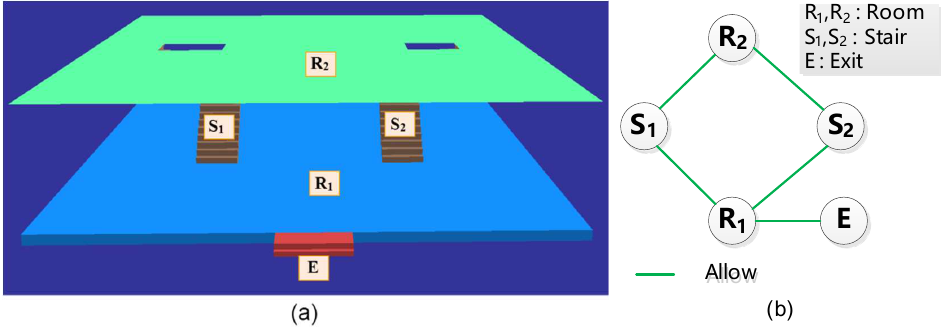
Figure 6. The spatial environment for Case 1: ( a ) the 3D spatial model; ( b ) the grid object network. The initial positions of individuals in Case 1 were set randomly throughout the 2nd